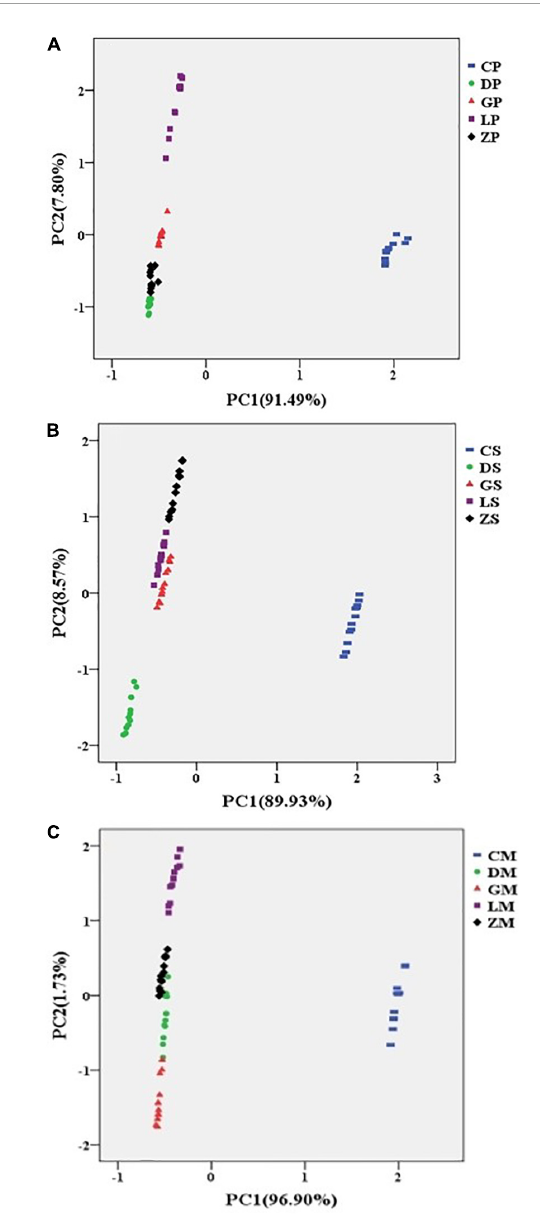
FIGURE5 Principal component analysis (PCA) plots of seasoning powder (A) , seasoning mixture sauce (B) , and the mixture of powder and sauce (C) using combined